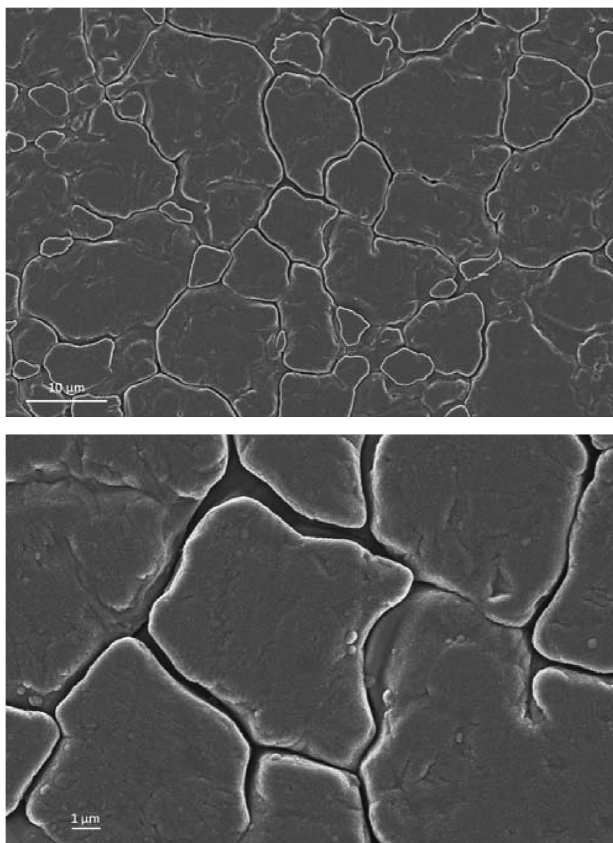
FIG. 6. Secondary electron image of an amorphous carbon thin film tested for heavy-ion induced desorption at LINAC 3. The 510-nm-thick sputter-coated film was deposited onto a stainless steel substrate, its grain structure is visible through the